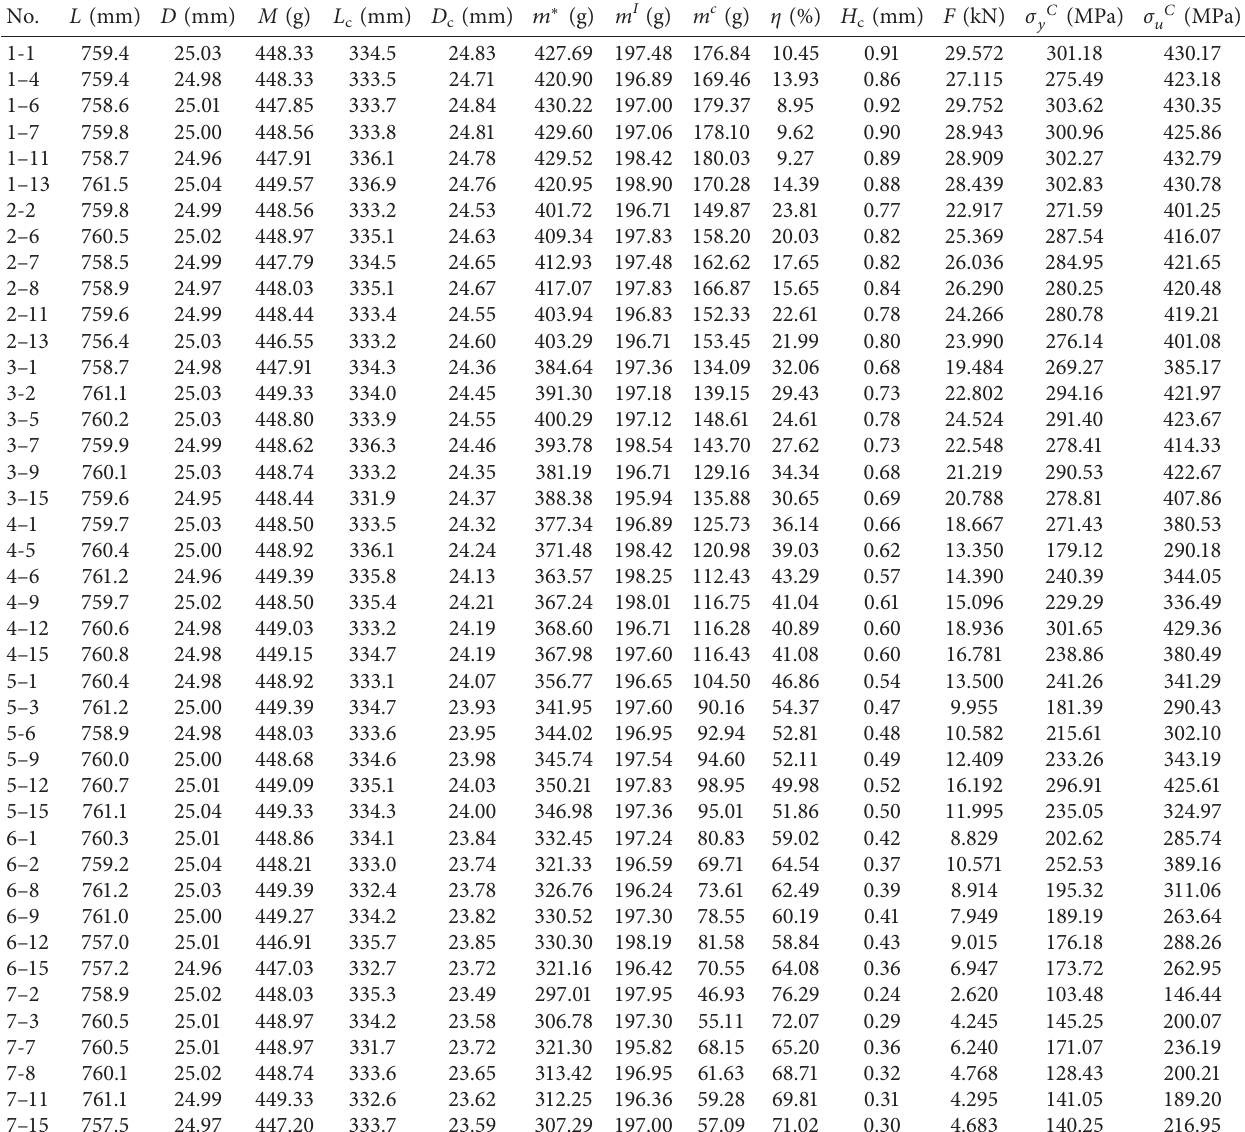
Table 2: Detailed information on the selected corroded